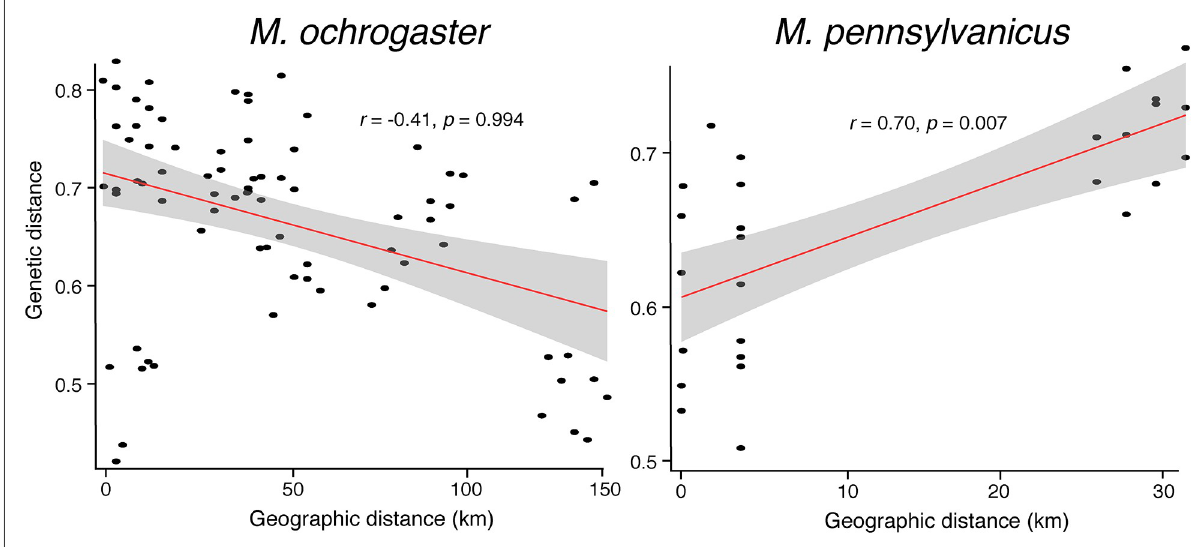
Fig 4. Patterns of isolation-by-distance among M . ochrogaster and M . pennsylvanicus . For M . ochrogaster estimates are based on samples from five SAFE sites (= Livingston, Montgomery, Pontiac, Prairie Ridge, and Saybrook) and for M . pennsylvanicus on two sites (= Livingston and Saybrook). The X-axis represents pairwise geographic distances computed from latitude and longitude coordinates, whereas the Y-axis represents genetic distances computed among localities using allele frequencies for 15 microsatellite loci. Lines represent linear models, with confidence intervals in gray. Numbers above linear regression lines represent Mantel r and p -values estimated from 999 random